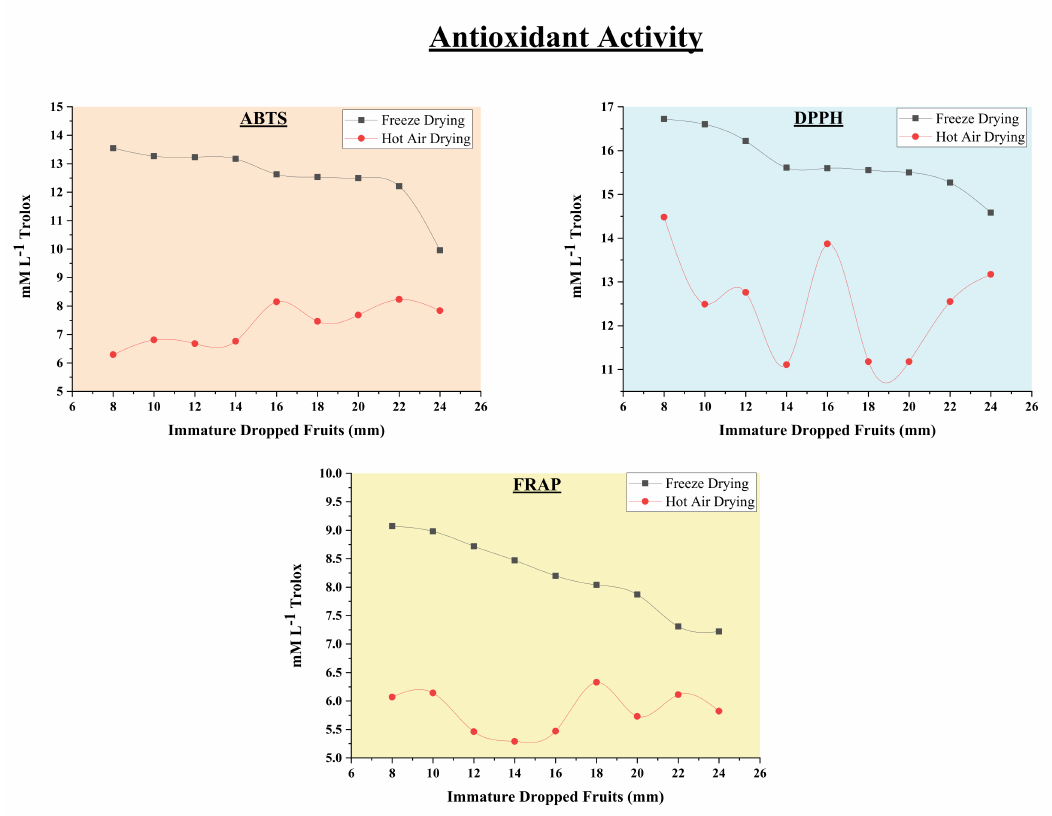
Figure 3. Antioxidant activity (ABTS, DPPH and FRAP assays) of immature mandarin ( Citrus reticulata Blanco) dropped fruits after freeze drying and hot air oven